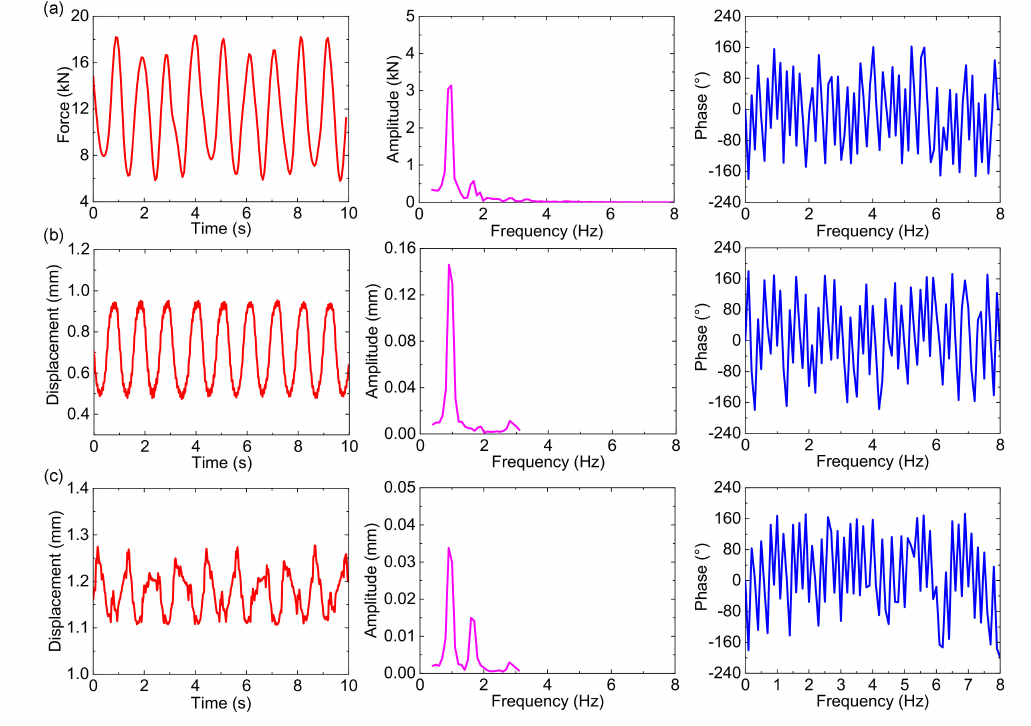
Figure 9. Time and frequency domain diagrams of horizontal excitation and response: ( a ) Horizontal excitation force; ( b ) horizontal displacement on the left side; ( c ) horizontal displacement on the right